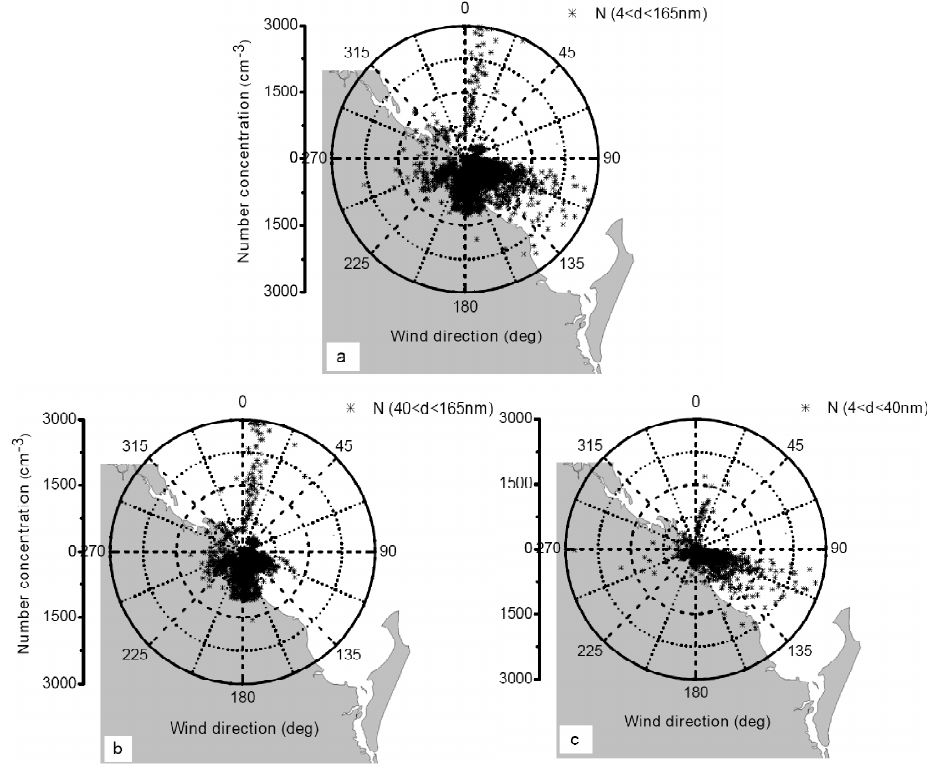
Fig. 2. Polar plots of number concentration against wind direction for particles in the size range (a) 4–165nm, (b) 40–165nm and (c)